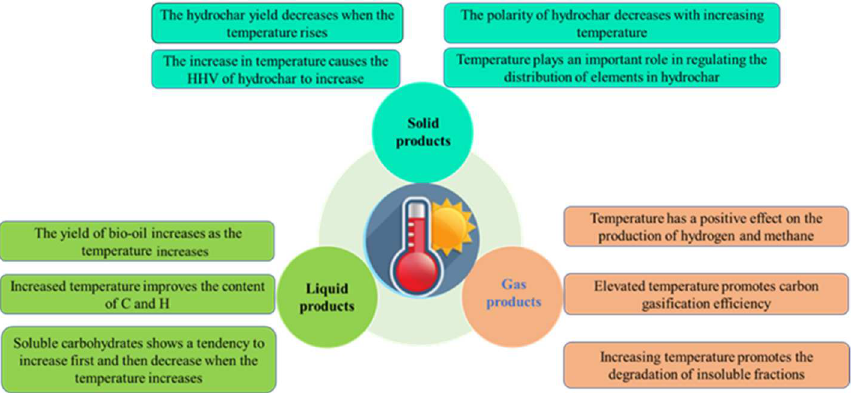
Figure 3. The influence of temperature on hydrothermal products.